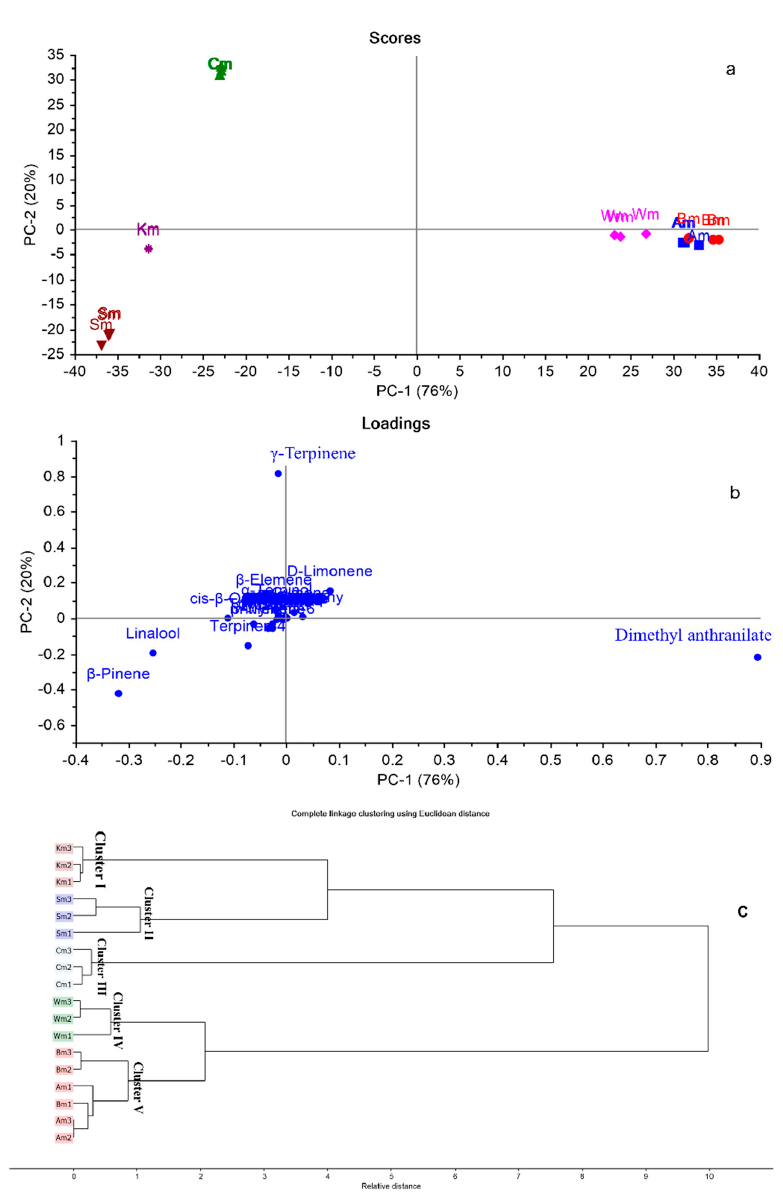
Figure 1. PCA score plot ( a ), loading plot ( b ), HCA dendogram ( c ) based on GC-MS metabolic profiles of different citrus cultivars based on the identification of volatile compounds displayed in Table 2. Refer to Table 1 for cultivar abbreviations. PCA score plot (Figure 1a) explained about 96% of the variation in the dataset by